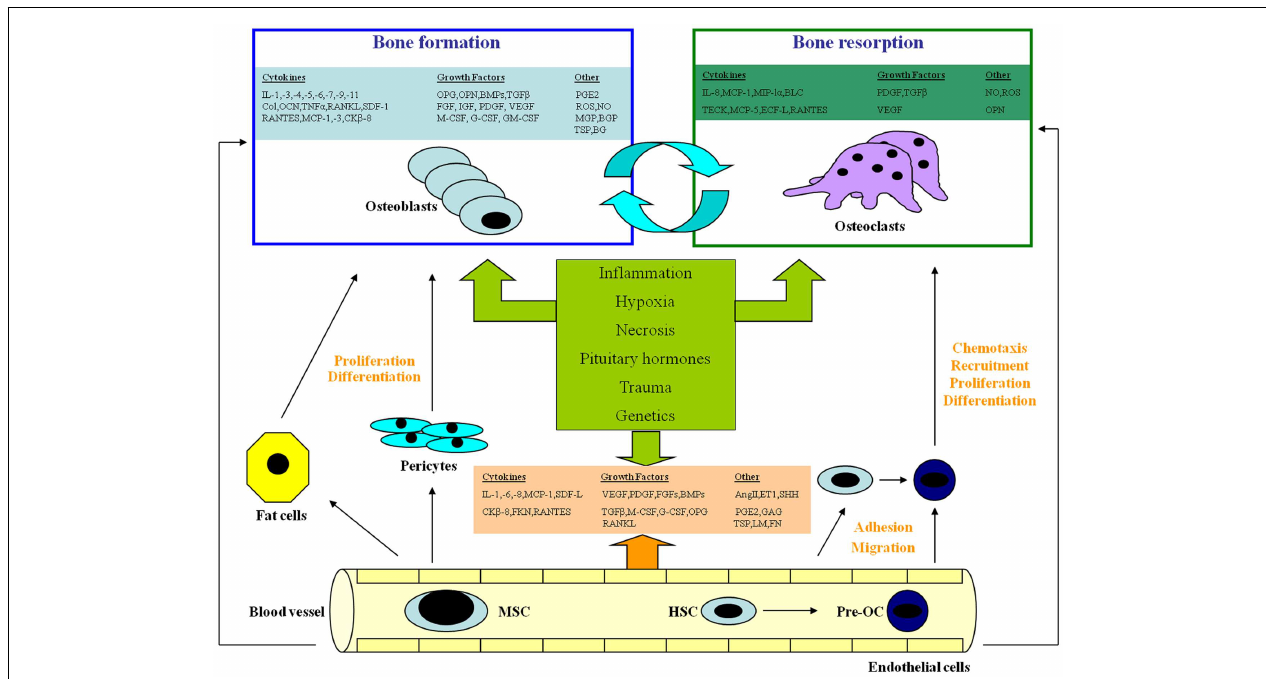
factor; FGFs, fibroblast growth factors; OPG, osteoprotegerin; BMPs, bone morphogenetic proteins;TGF, transforming growth factor; M-CSF, macrophage-colony stimulating factor; G-CSF, granulocyte-colony stimulating factor; GM-CSF, granulocyte/macrophage-colony stimulating factor; Ang II, angiotensin-II; PGE2, prostaglandin E2; ROS, reactive oxygen species; ET-1, endothelin-1; SHH, Sonic Hedgehog; OCN, osteocalcin; OPN, osteopontin; ON, osteonectin; MGP, matrix Gla protein; BGP, bone Gla protein; BG, biglycan; IGFs, insulin-like growth factors; BLC, B-lymphocyte chemoattractant;TECK, thymus-expressed chemokine; ECF-L, eosinophil chemotactic